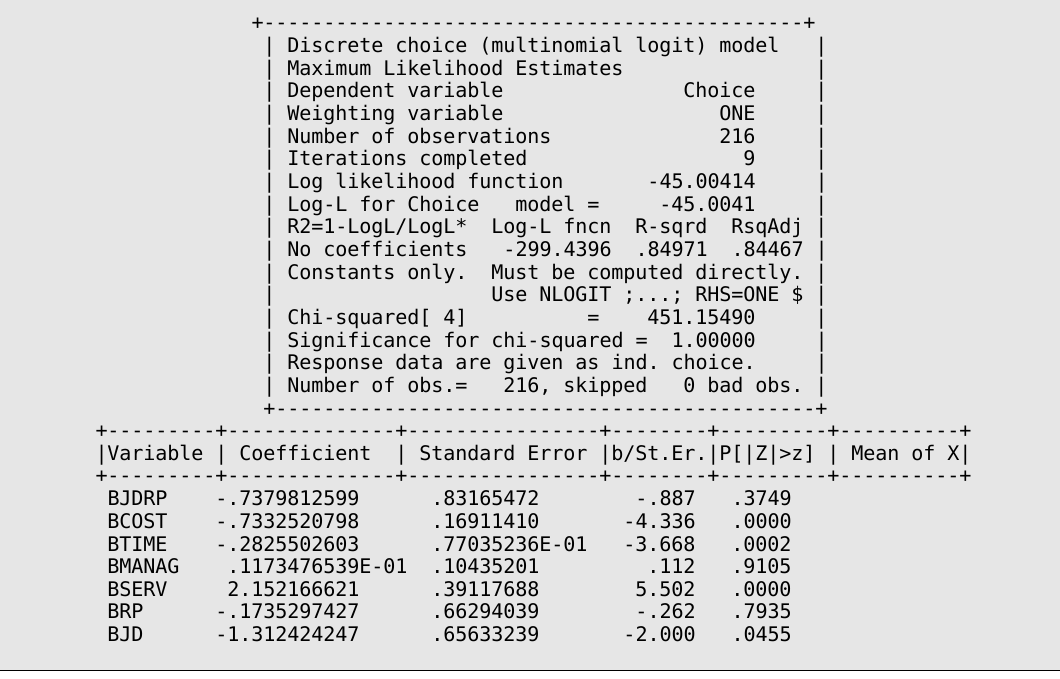
Figure 4. Output report provided by Limdep® for the non-hierarchical logit